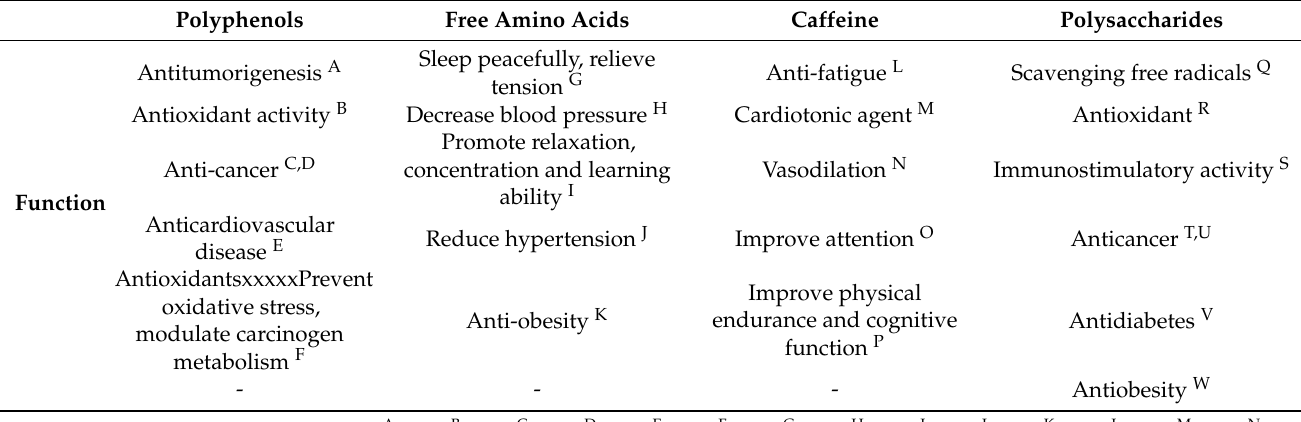
Table 2. The biological functions of main secondary metabolites in